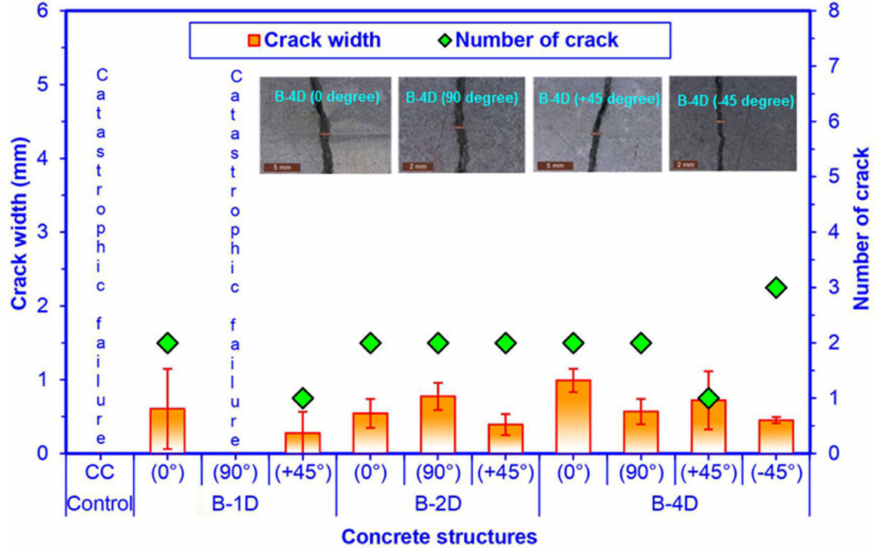
Figure 18. Number of cracks and crack width in fractured multiaxis 3D basalt fiber concretes after off-axis four-point flexure